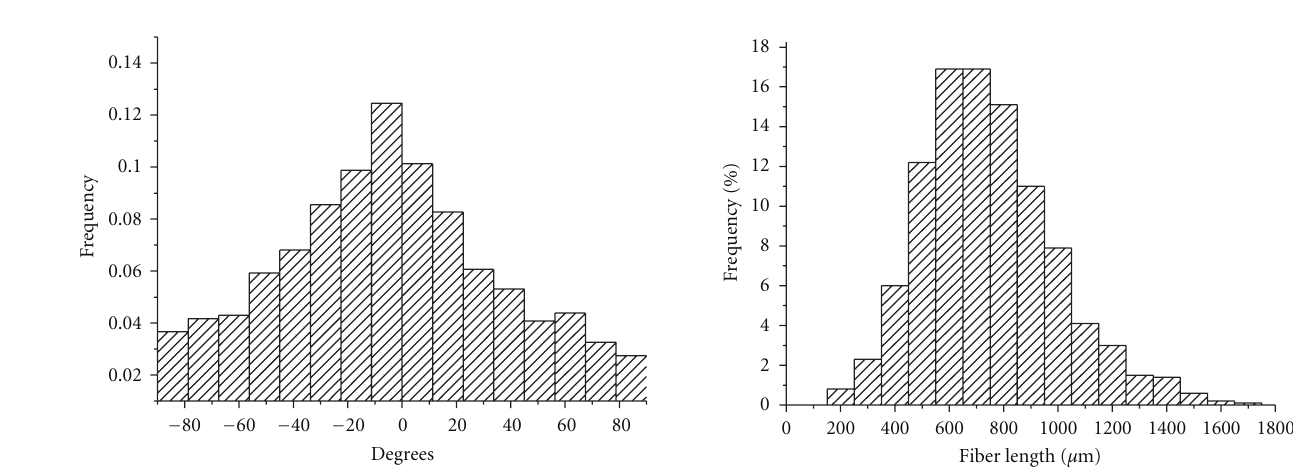
Figure 2: Fiber length distribution of PLA composite (sisal fiber content of 30%).